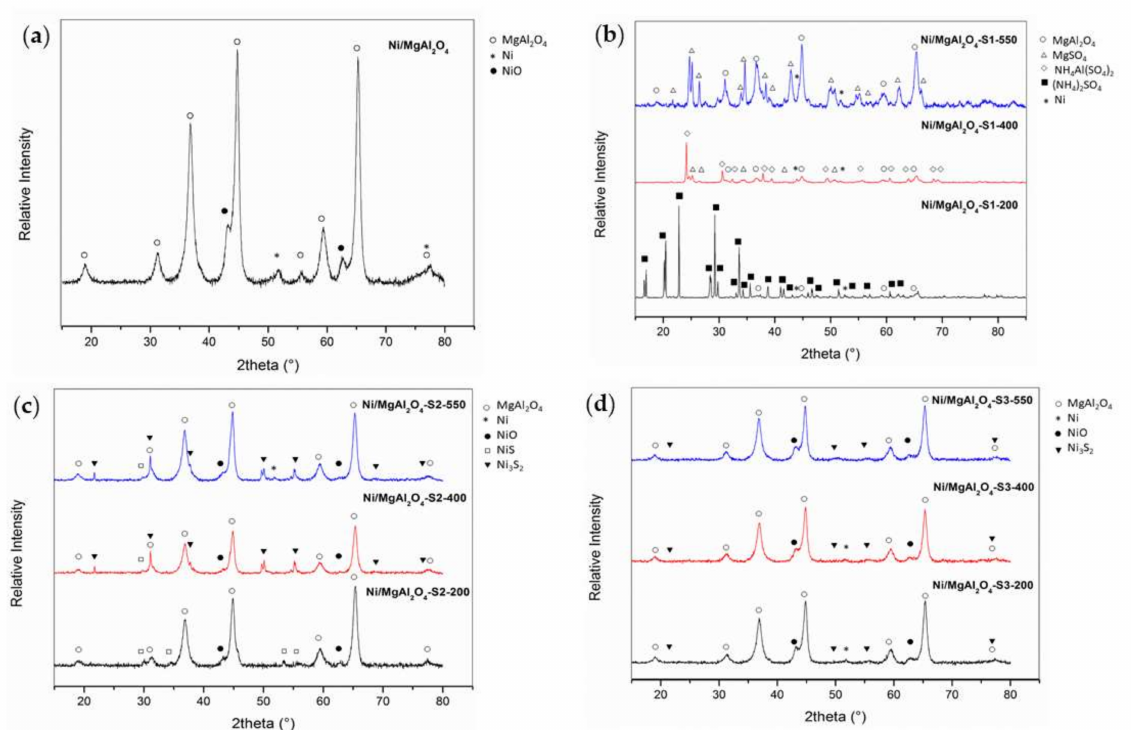
Figure 1. ( a ) XRD pattern of Ni/MgAl 2 O 4. ( b ) XRD pattern of Ni/MgAl 2 O 4 -S1 sulfided at 200 ◦ C, 400 ◦ C, and 550 ◦ C. ( c ) XRD pattern of Ni/MgAl 2 O 4 -S2 sulfided at 200 ◦ C, 400 ◦ C, and 550 ◦ C. ( d ) XRD pattern of Ni/MgAl 2 O 4 -S3 sulfided at 200 ◦ C, 400 ◦ C, and 550 ◦ C. The XRD patterns of Ni/MgAl 2 O 4 sulfided with (NH 4 ) 2 SO 4 (S1) to form Ni/MgAl 2 O 4